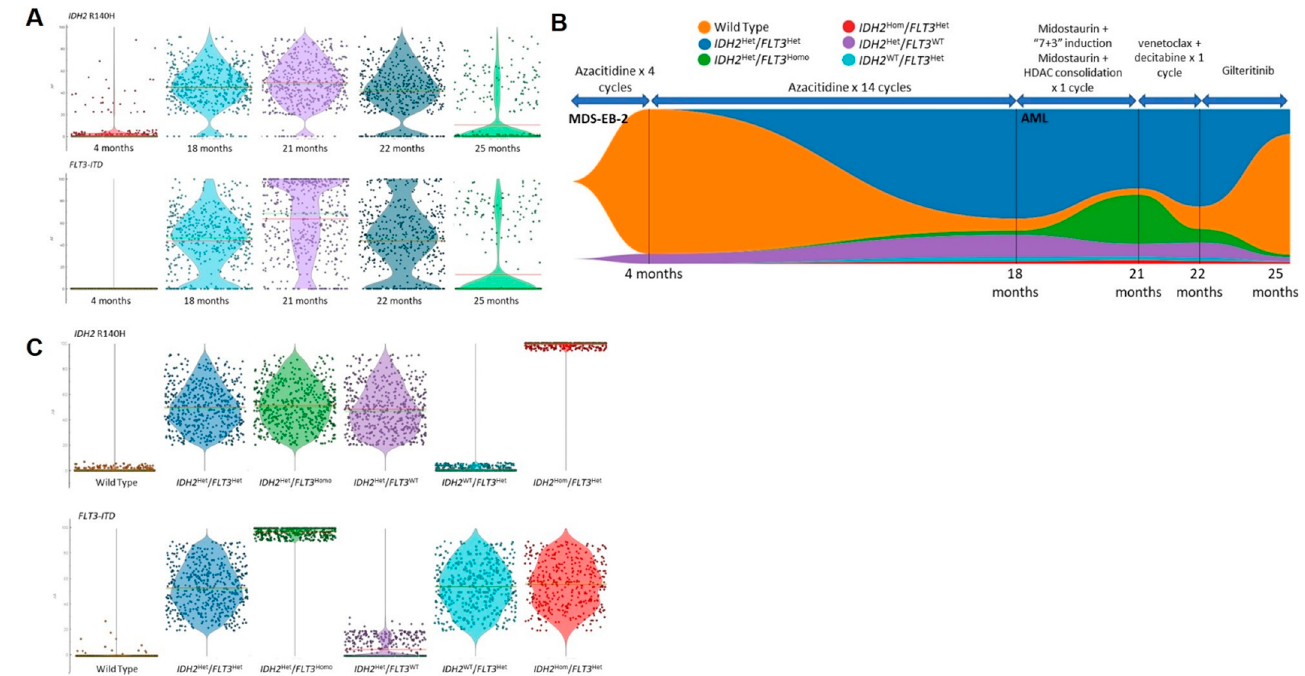
Figure 2. Clonal evolution of IDH2 R140H and FLT3 -ITD mutations in Patient 1. ( A ): Overall VAFs for IDH2 R140H and FLT3-ITD across different time points evaluated; ( B ): Fish plot showing the evolution of WT, FLT3-ITD, and IDH2 R140H clones serially with treatment; ( C ): VAFs of IDH2 R140H and FLT3-ITD mutations at the sub-clonal level. Red and green lines on the violin plots represent median and mean VAFs, respectively.